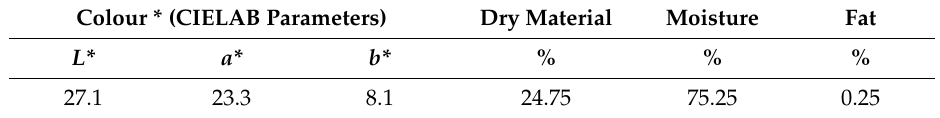
Table 2. Colour parameters, moisture and fat content (%) in Cornus mas L. fruits.